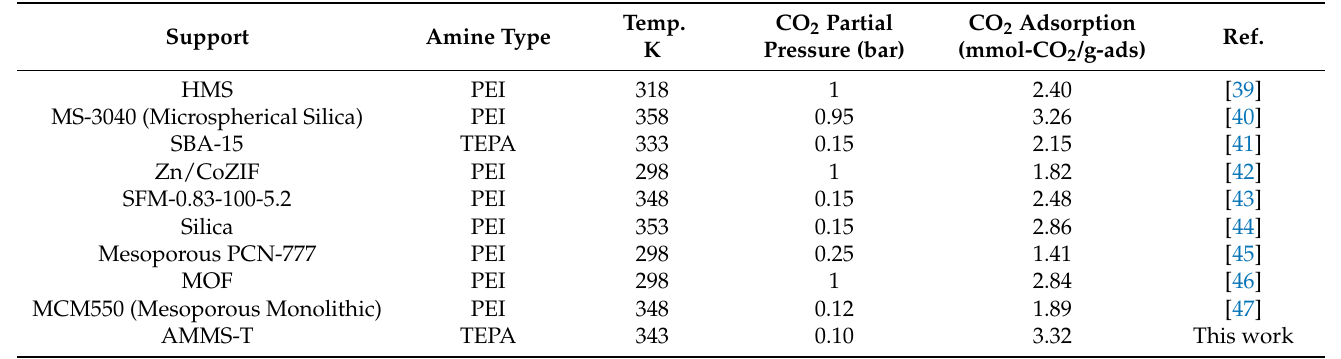
Table 4. Comparison of CO 2 adsorption capacity of AMMS-T (present study) with the